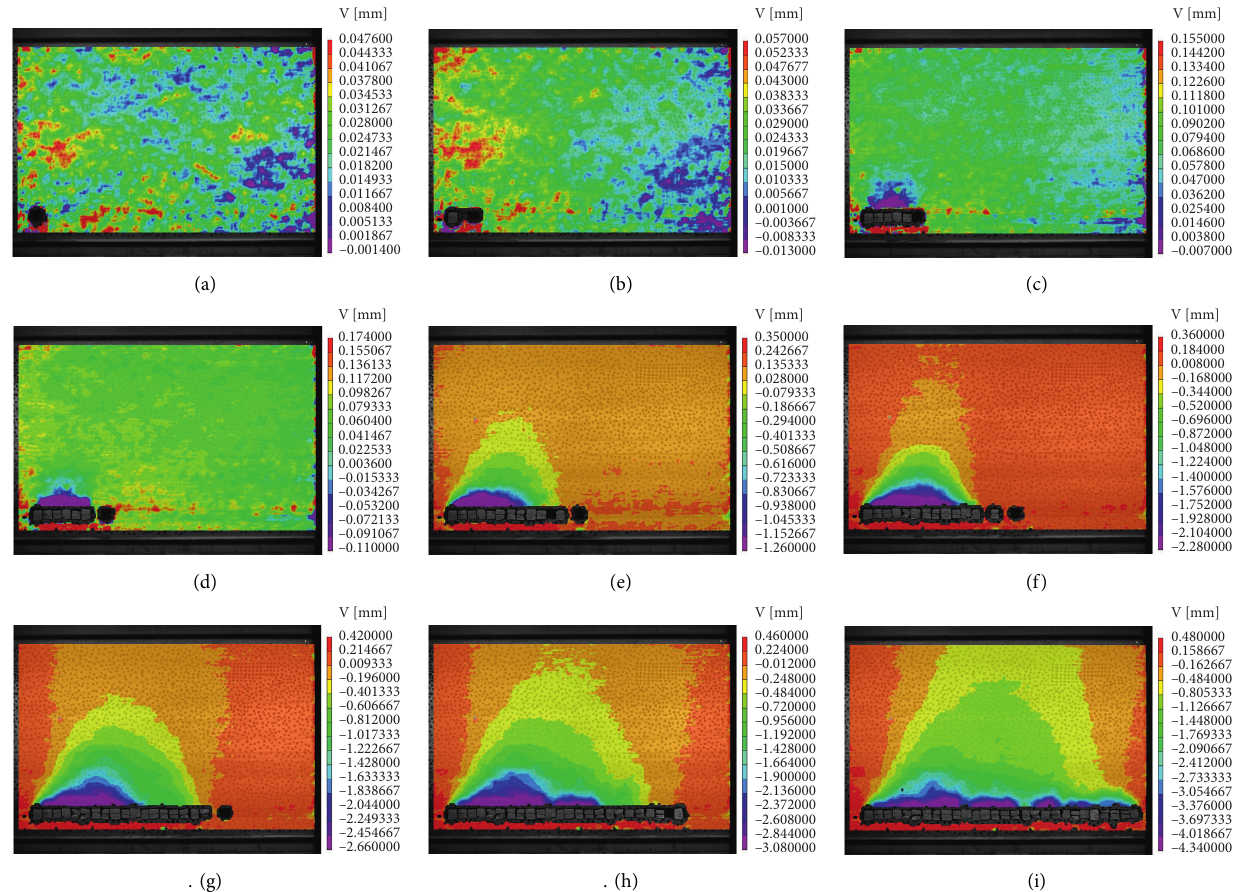
Figure 12: Evolution of the vertical displacement field of the overlying strata during the filling and mining process. (a) 5m. (b) 15m. (c) 30m. (d) 40m. (e) 60m. (f) 80m. (g) 100 m. (h) 120 m. (i) 140